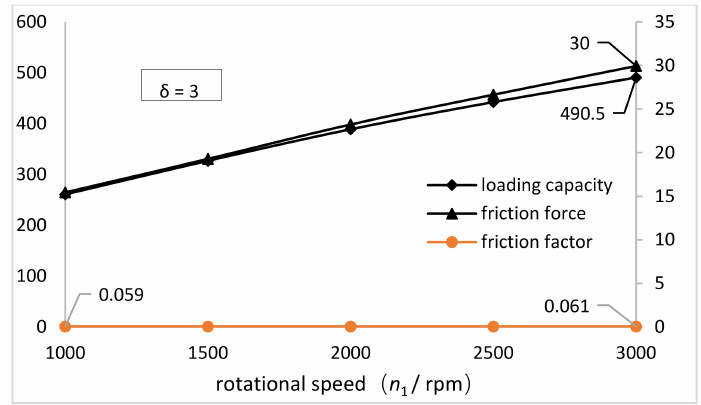
Figure 11. Variations of the loading capacity and friction force and friction factor on the inner wall of the FS with the rotational speed of the NFWG ( δ = 3).